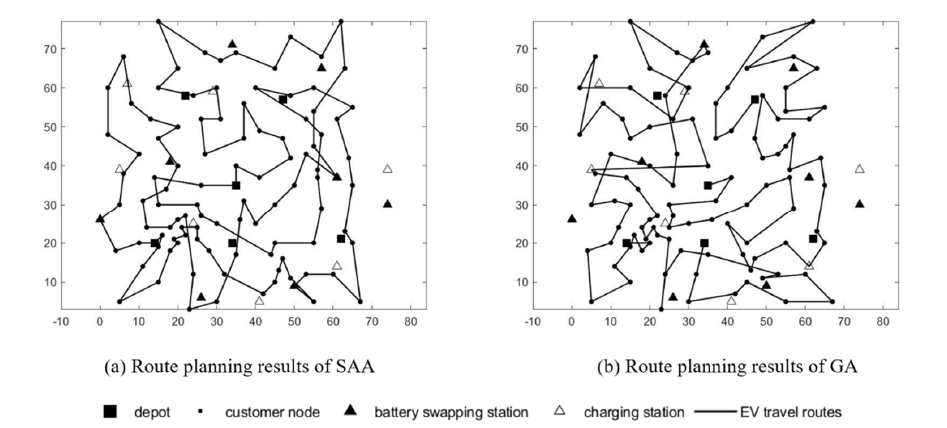
Fig. 5. Planning scheme of the HOTDMDEVRPBRS under different optimization